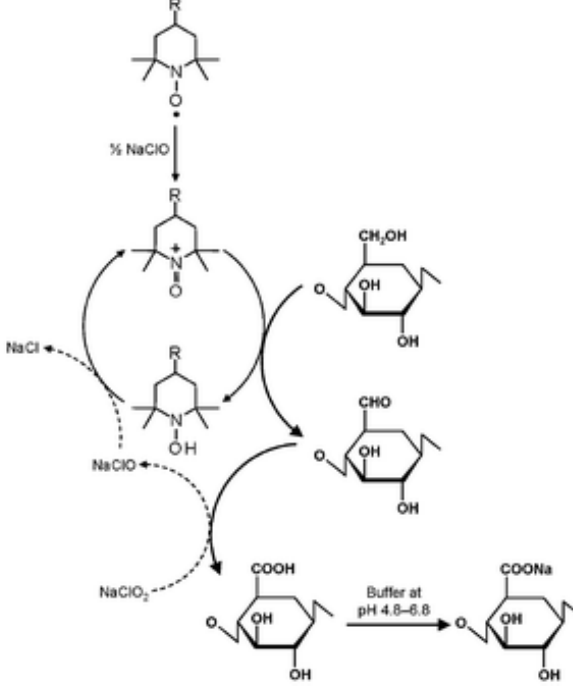
Figure 5: Oxidation of Cellulose by TEMPO/NaBr/NaClO at pH 10- 11. Reproduced from [119] with permission of the Royal Society of Chemistry.